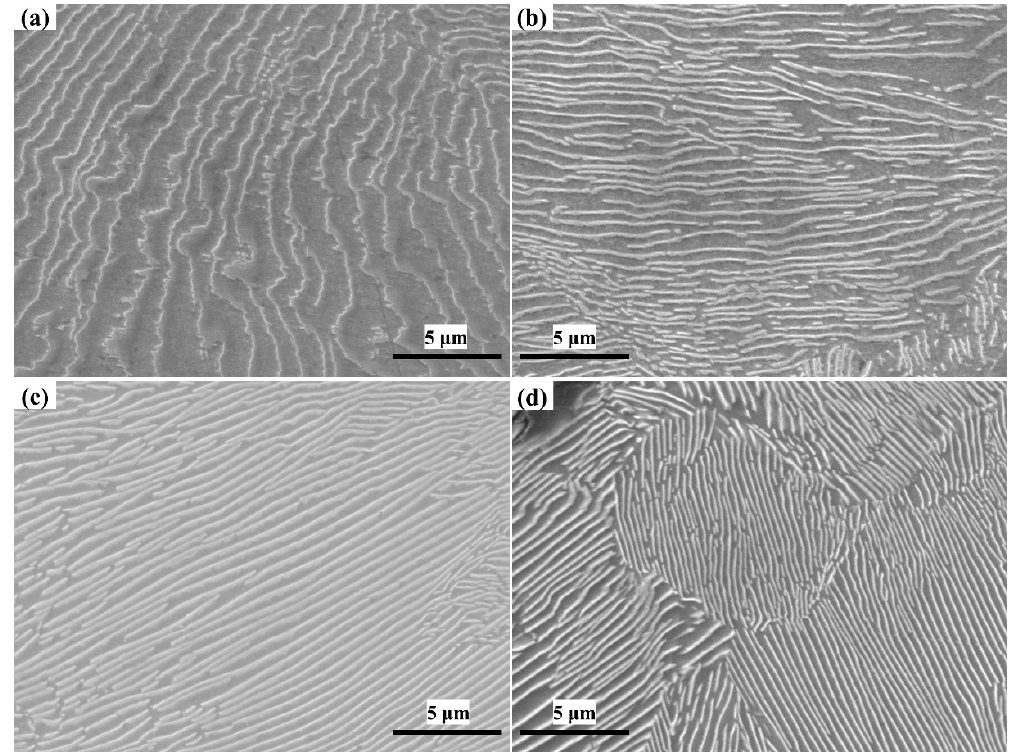
Figure 10. The pearlite structure with different niobium content. ( a ) 0% Nb; ( b ) 0.098% Nb; ( c ) 0.27% Nb; ( d ) 0.46% Nb.